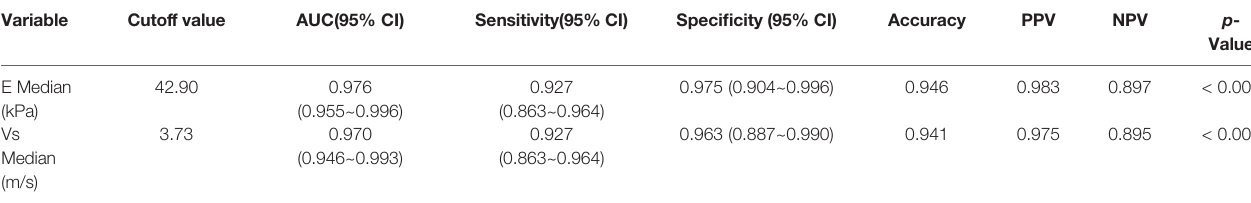
TABLE 4 | Diagnostic performances of SWE examined malignant LNs.